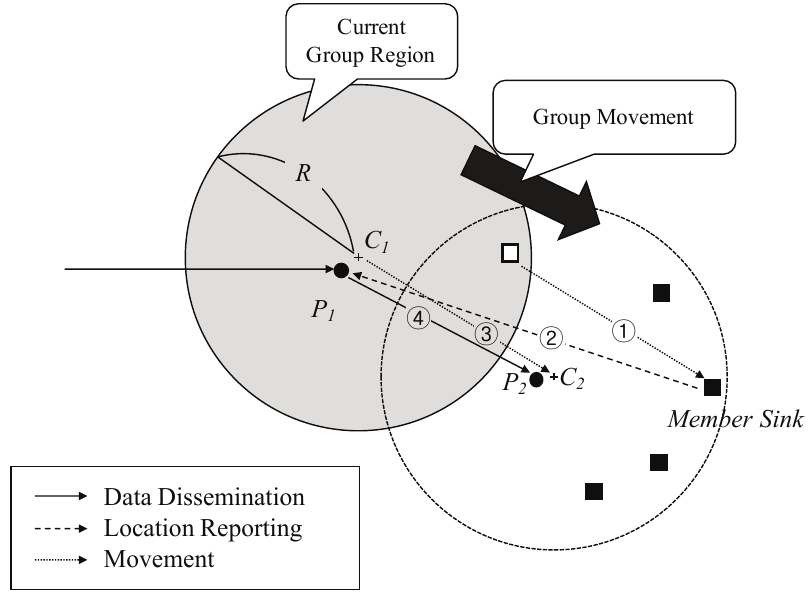
Figure 3. The region shift